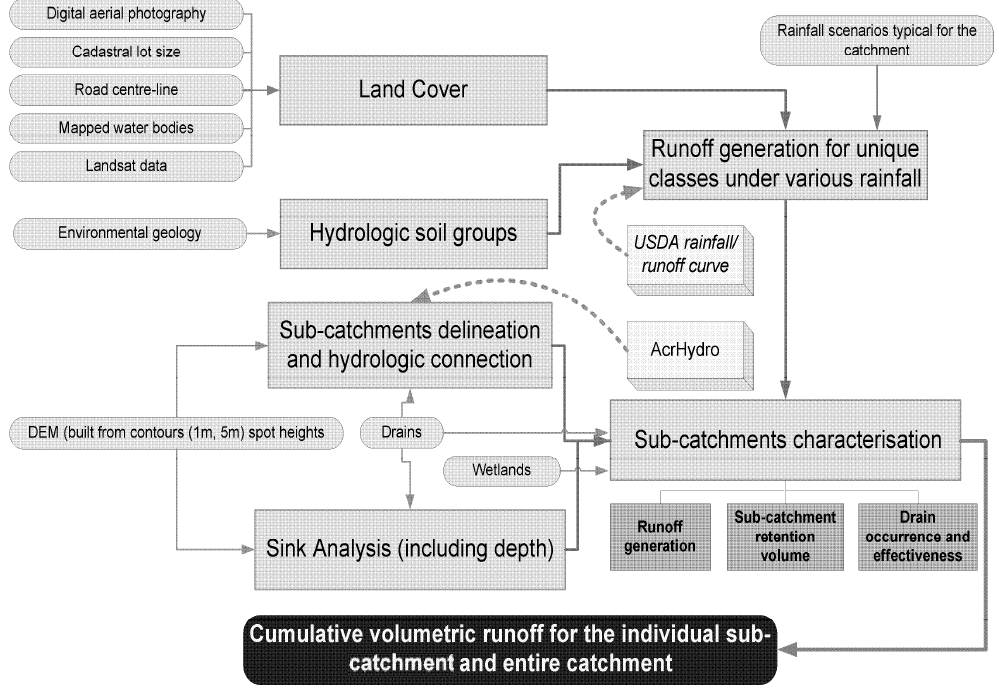
Figure 3. Framework for Catchment Contributing Area Analysis Fig. 3. Framework for Catchment Contributing Area Analysis.